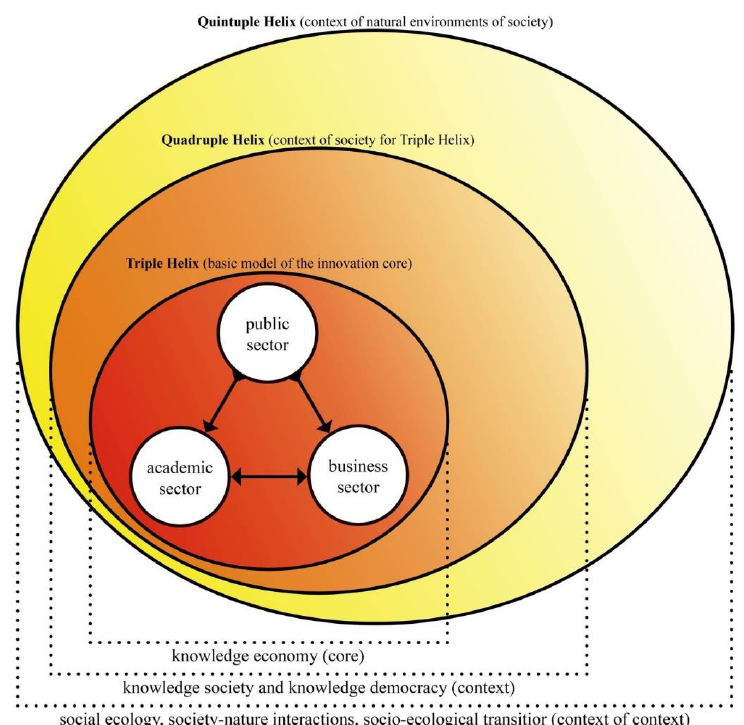
Figure 6. “Quintuple helix” adapted from Gouvea et al . [30].